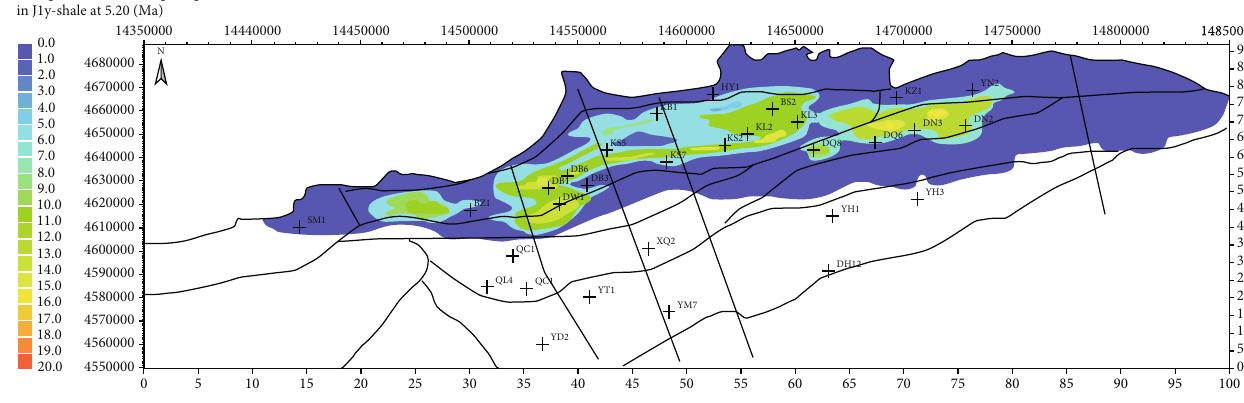
y source rock (5.2 1